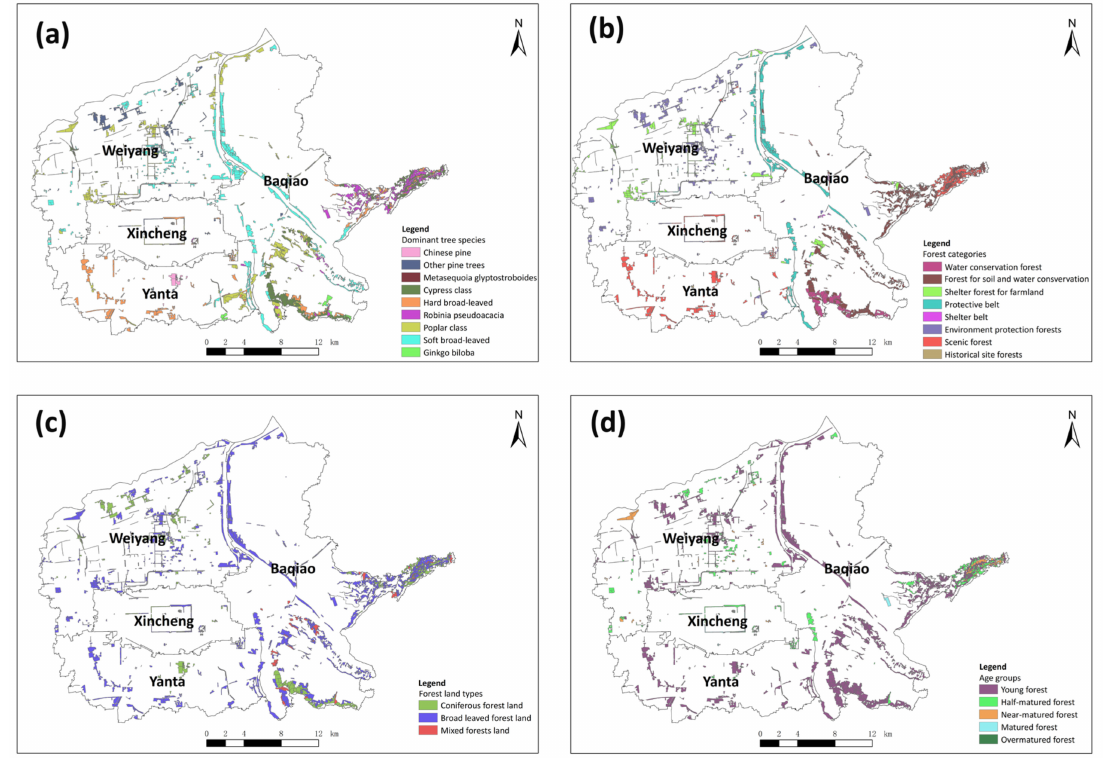
Figure 3. The whole study area was split into di ff erent subtypes according to GFs: ( a ) Dominant tree species; ( b ) forest categories; ( c ) forestland types; and ( d ) age